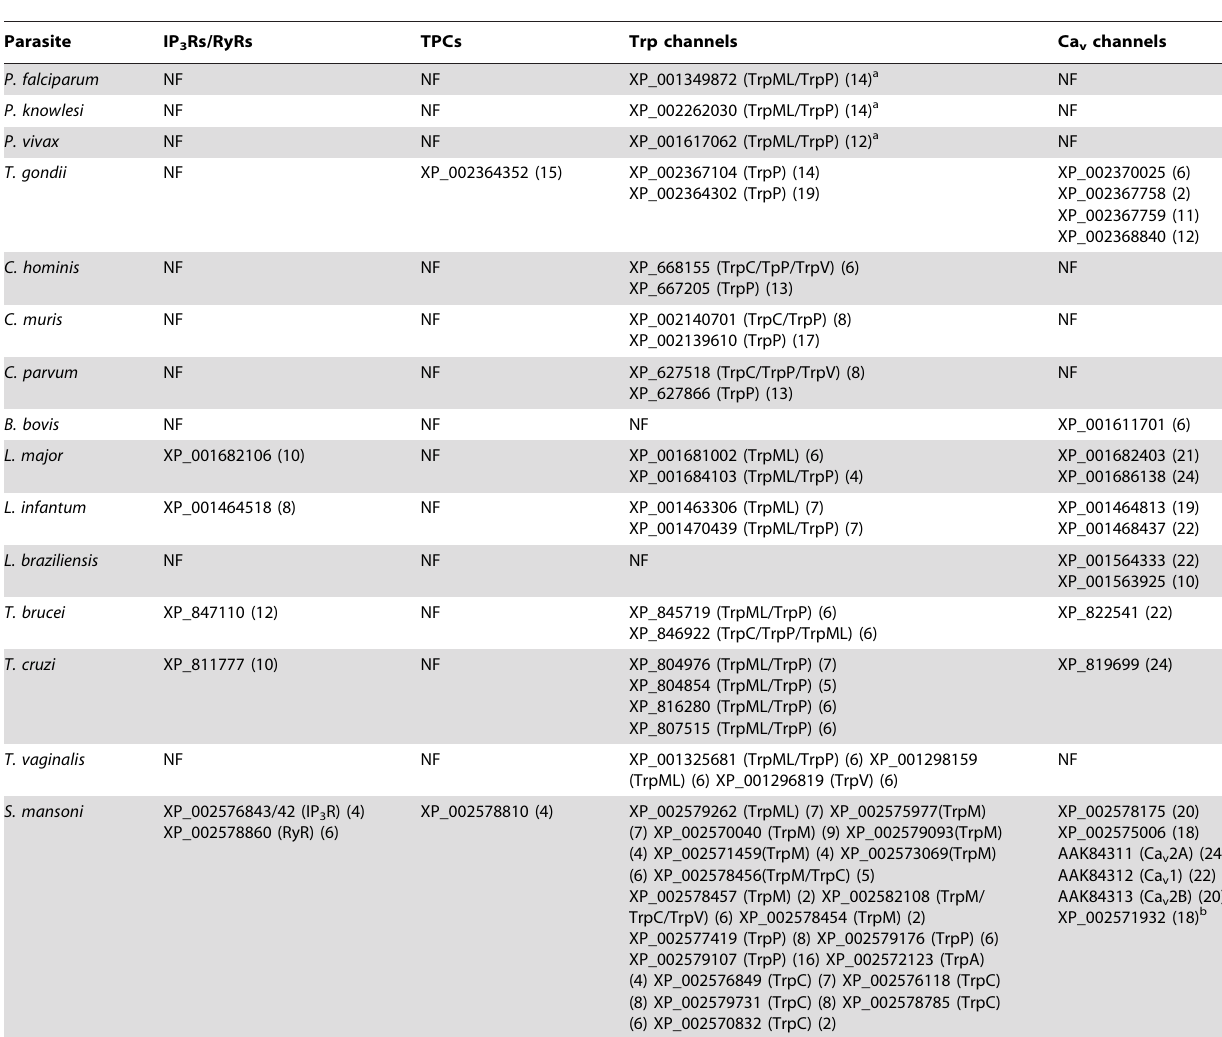
Table 2. Identity of Ca 2 + channel homologues in pathogenic parasites.